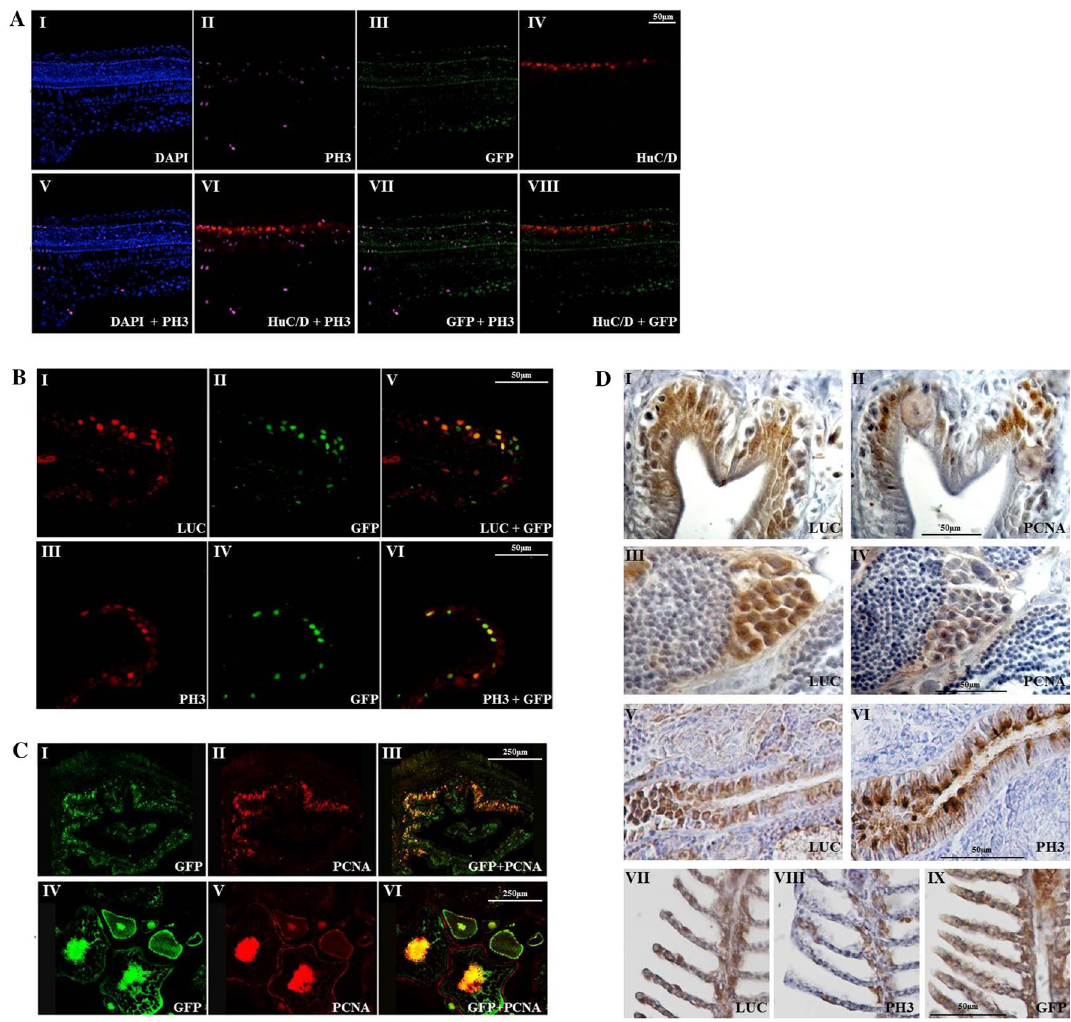
Figure 4. Proliferation markers colocalize with GFP and luciferase proteins in MITO-Luc/GFP zebrafish tissues . ( A ) Immunofluorescence analysis of DAPI (I), pH3 (II), GFP (III), HuC/D(IV), DAPI-pH3